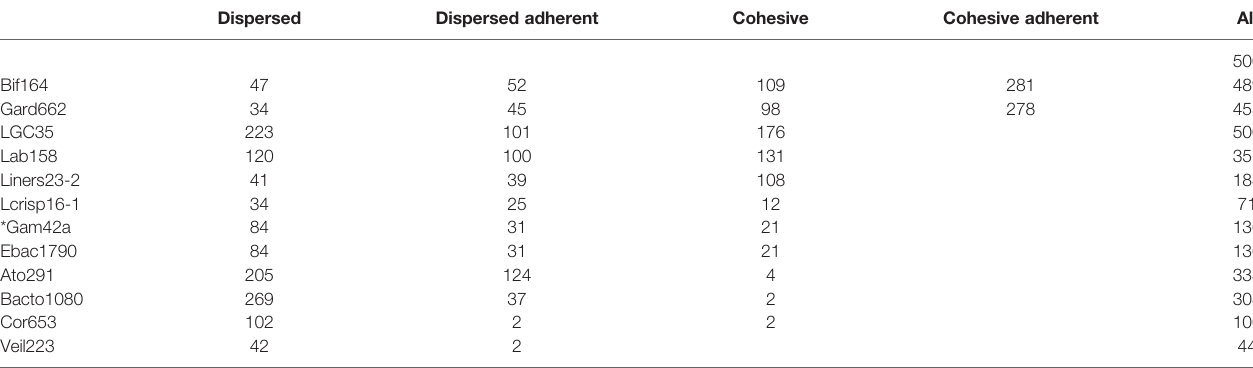
TABLE 1 | Number of patients/samples demonstrating different patterns of spatial distribution for each of the investigated groups.